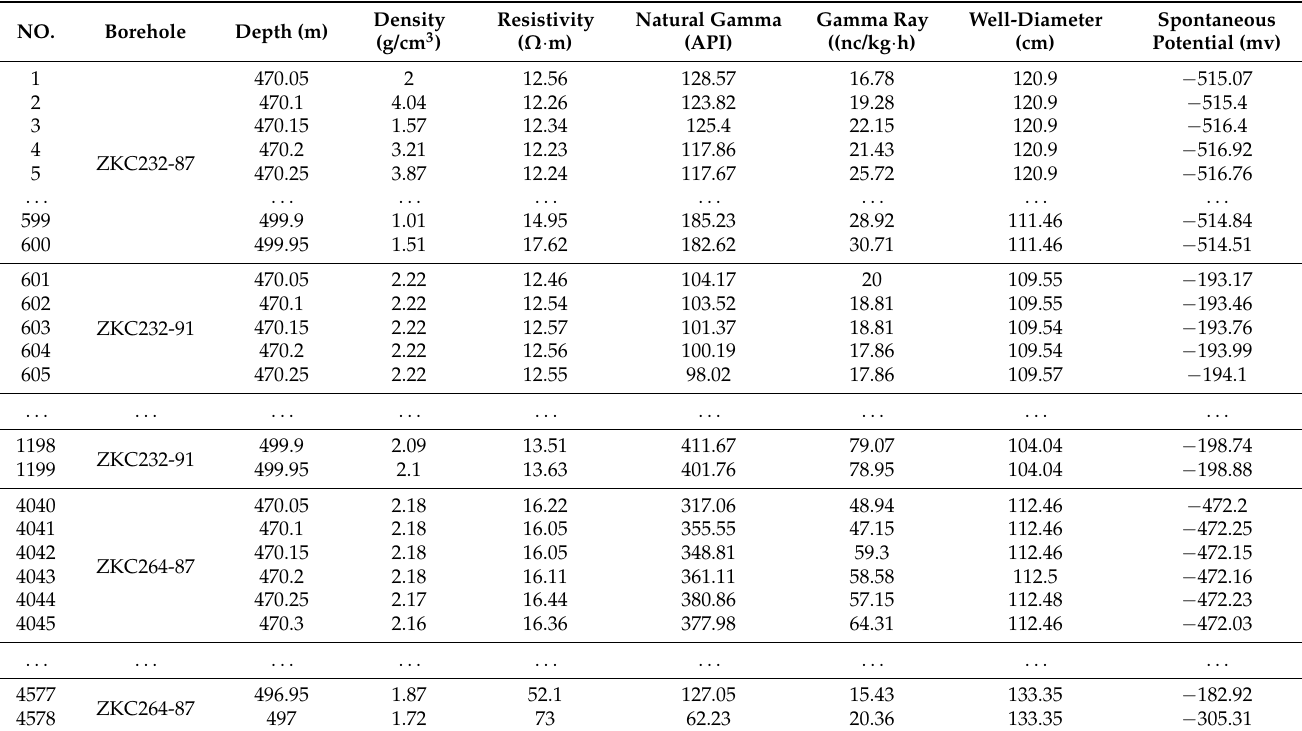
Table 1. Summary of 4578 sample data of the Tarangaole deposit.